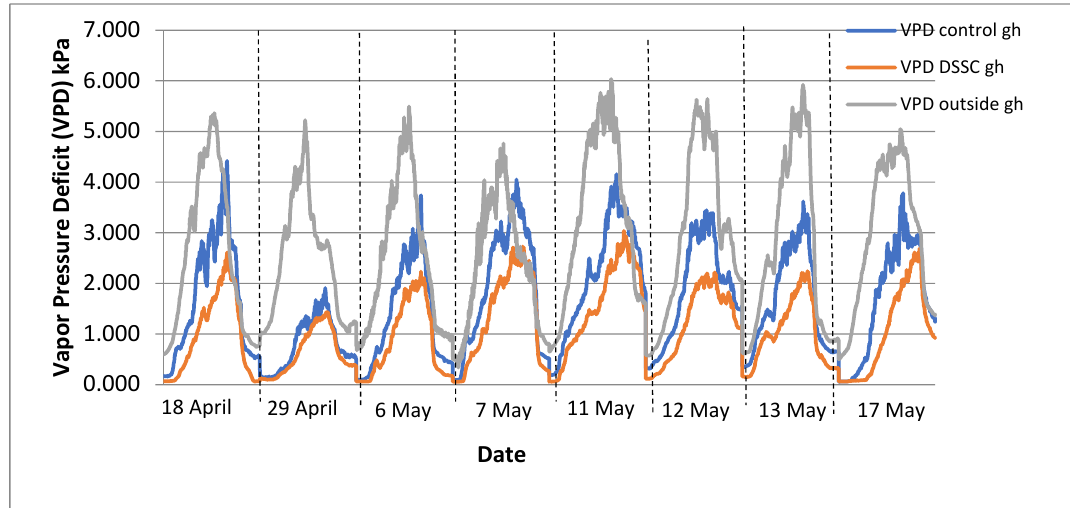
Figure 5. Vapor Pressure Deficit (VPD) outside and inside greenhouses.